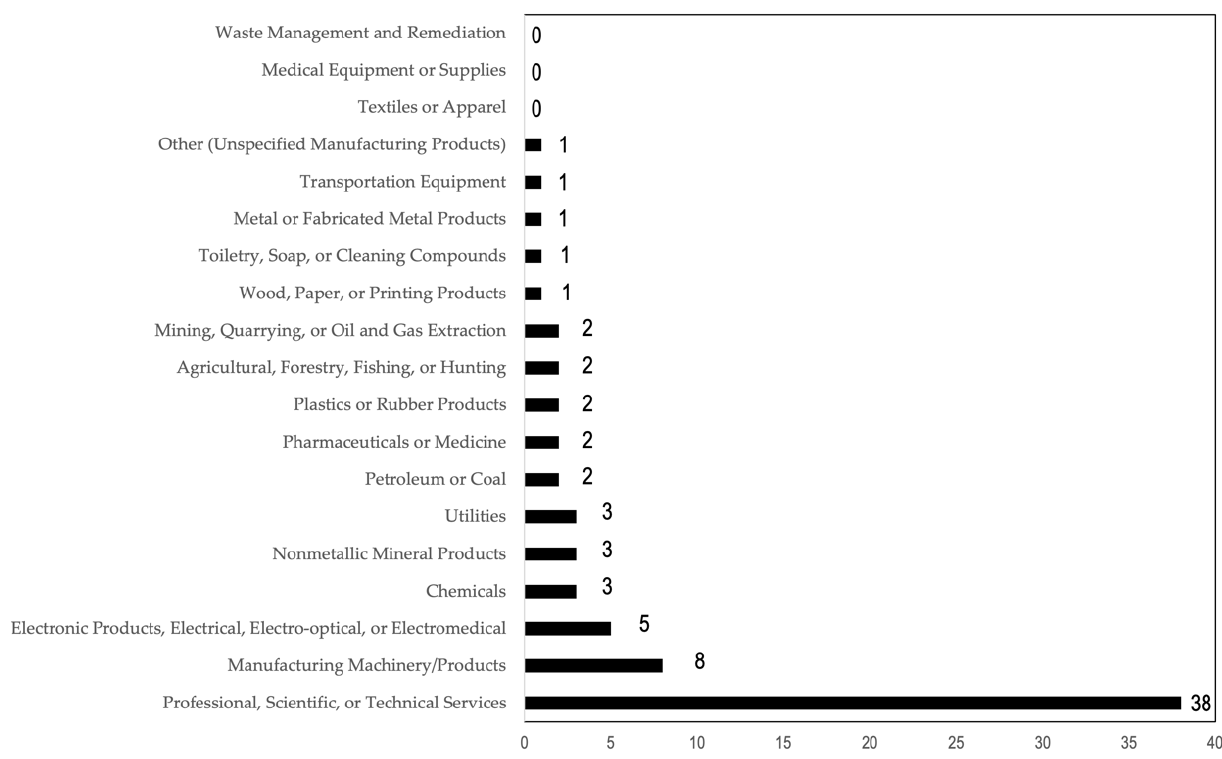
Figure 2. Commercial Sector for ENM Use. The majority of the companies reported ENM use for professional, scientific, or technical services (n = 38; 84.4%). Note: multiple responses allowed; missing n = 1.